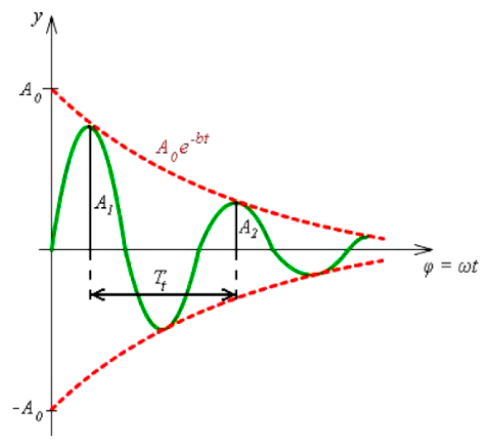
Figure 10. The schematic representation of attenuation λ in muted oscillation motion.